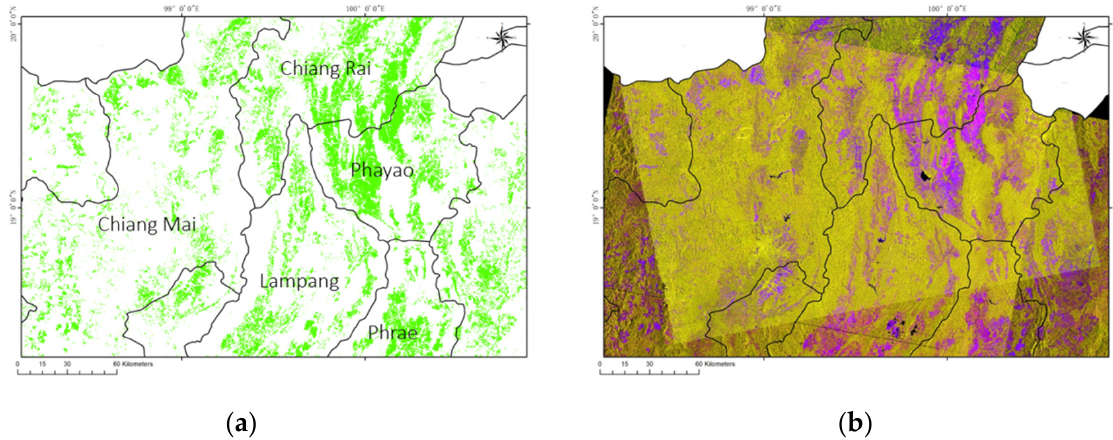
Figure 19. Paddy rice mapping result of Chiang Mai (northern Thailand): ( a ) paddy rice mapping result and ( b ) false-color image of the temporal features.